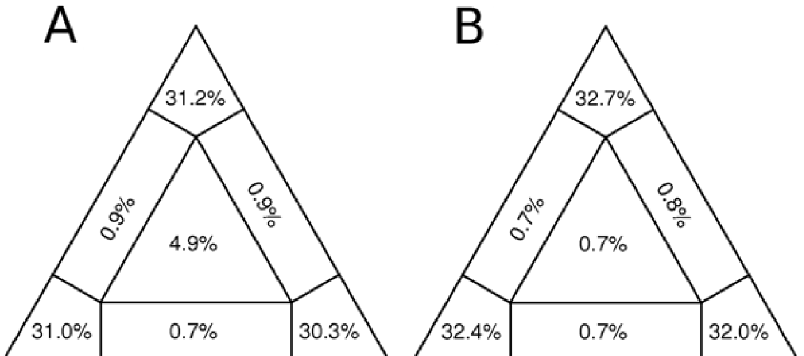
Figure 2. Likelihood mapping of the Fsp (A) and H (B) datasets. The probabilities close to the triangle corners represent tree-like topologies (well-resolved). Those in the center and on the sides represent star-like (unresolved) and network-like signals (partially unresolved), respectively.